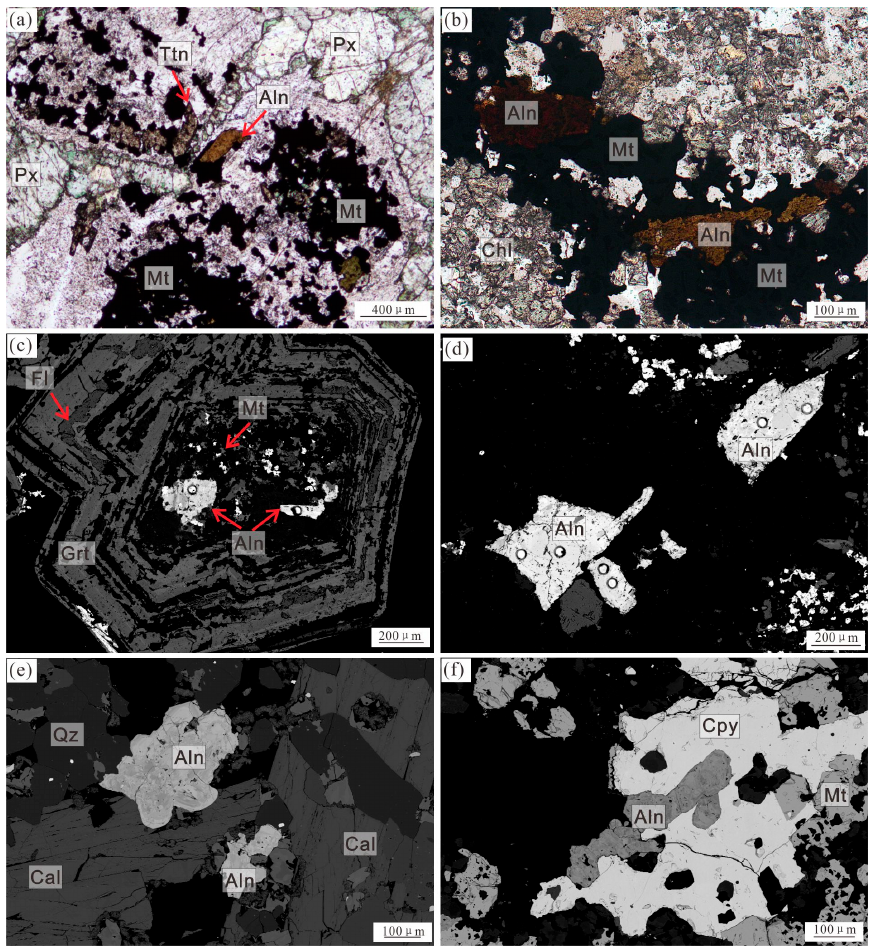
Figure 5. Photomicrographs and BSE images of the allanite from: the Beiya deposit ( a , c , d ); and the Machangqing deposit ( b , e , f ). Abbreviations: Aln, allanite; Cal, calcite; Chl-, chlorite; Cpy, chalcopyrite; Fl, fluorite; Grt, garnet; Mt, magnetite; Px, pyroxene; Py, pyrite; Qz, quartz; Ttn, titanite.